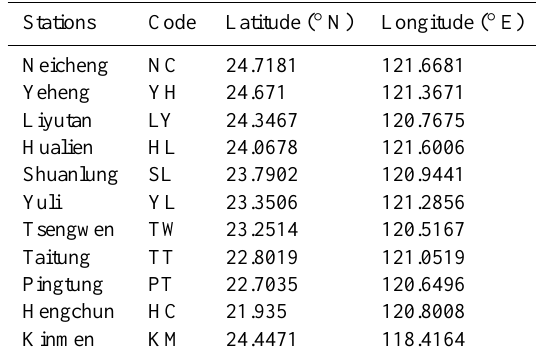
Table 1. Locations of 11 geomagnetic stations in Taiwan.